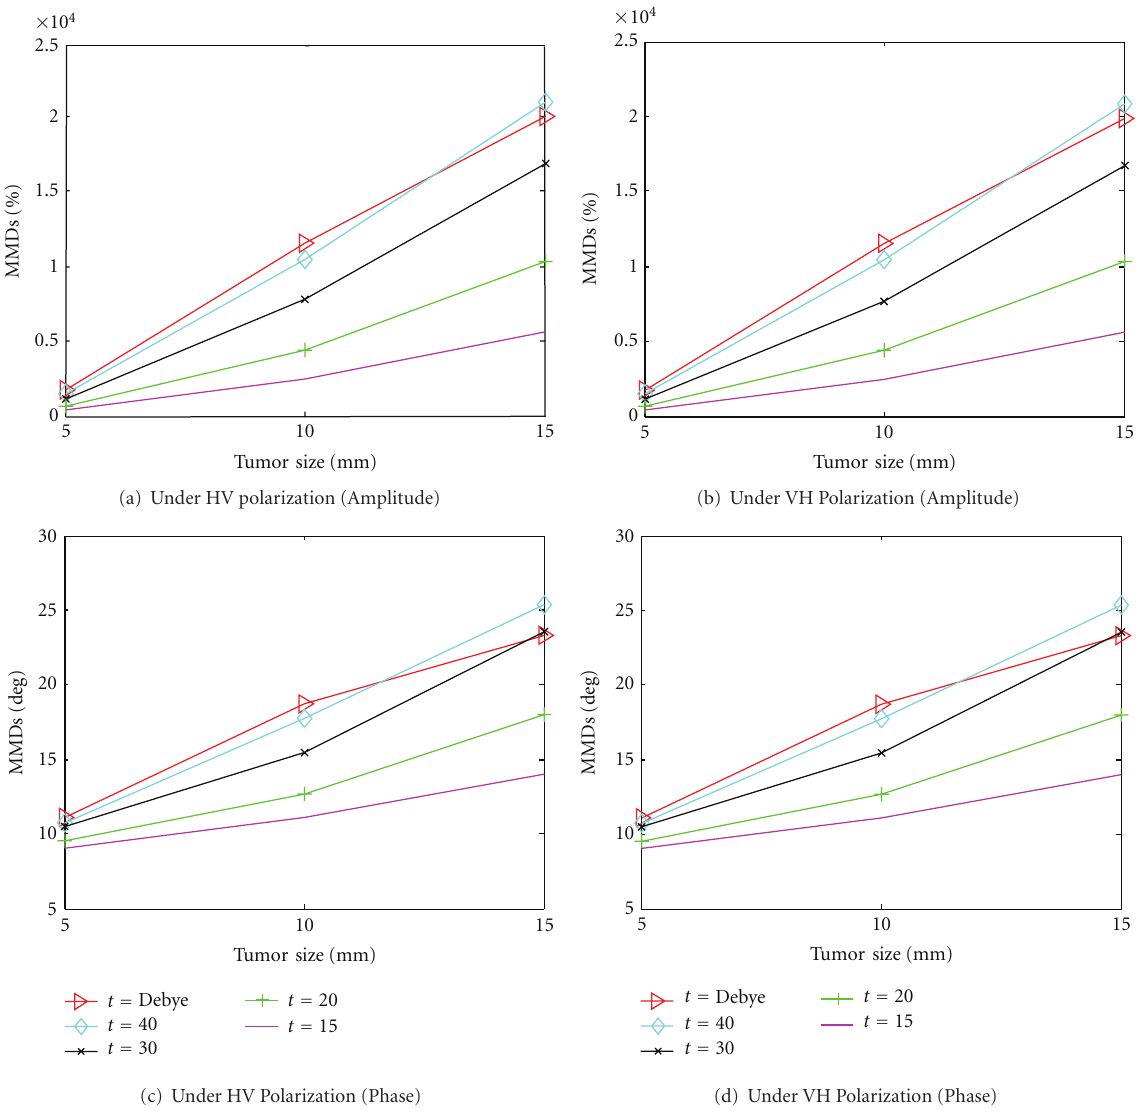
Figure 10: MMD AB ,amplitude and MM i AB ,phase for the scattering problems with tumor of di ff erent sizes. In each figure, three di ff erent dielectric properties of the tumor are considered (i) Debye (Figure 3), (ii) ε r = 40, σ = 0 . 1S/m, (iii) ε r = 30, σ = 0 . 1S/m, (iv) ε r = 20, σ = 0 . 1S/m, and (v) ε r = 15, σ = 0 . 1S/m. (a) MMD AB ,amplitude for HV polarization state, (b) MMD AB ,amplitude for VH polarization state, (c) MMD AB